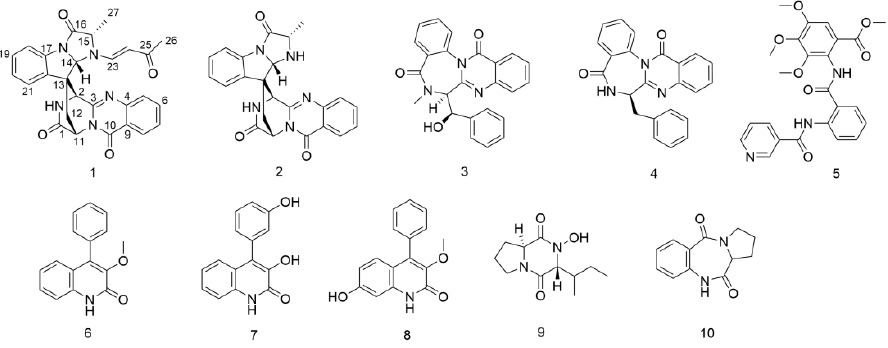
Figure 3. The structure of compounds 1–10.